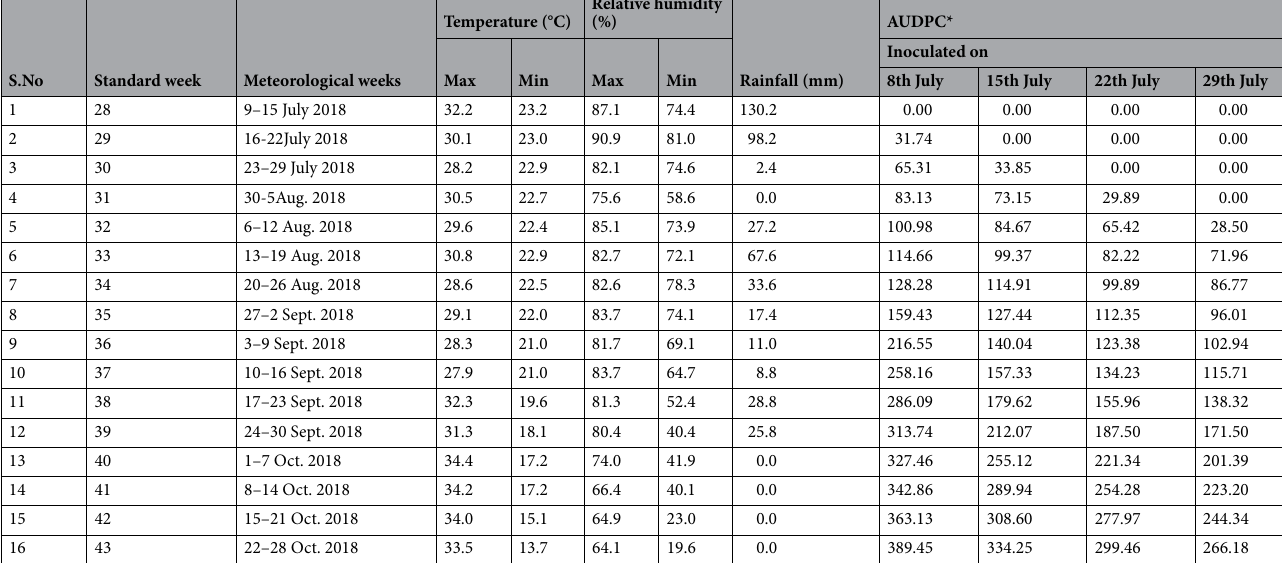
Table 3. Progression of Alternaria leaf spot on soybean in relation to weather parameters in different dates of sowing under epiphytotic conditions during Kharif 2018. *Mean of three replications, Inoculation started 21 days after sowing of each date. *Observation started 7th days after inoculation and at weekly intervals, 1st sown-18th June, 2nd–25th June, 3rd–02th July, 4th–09th July